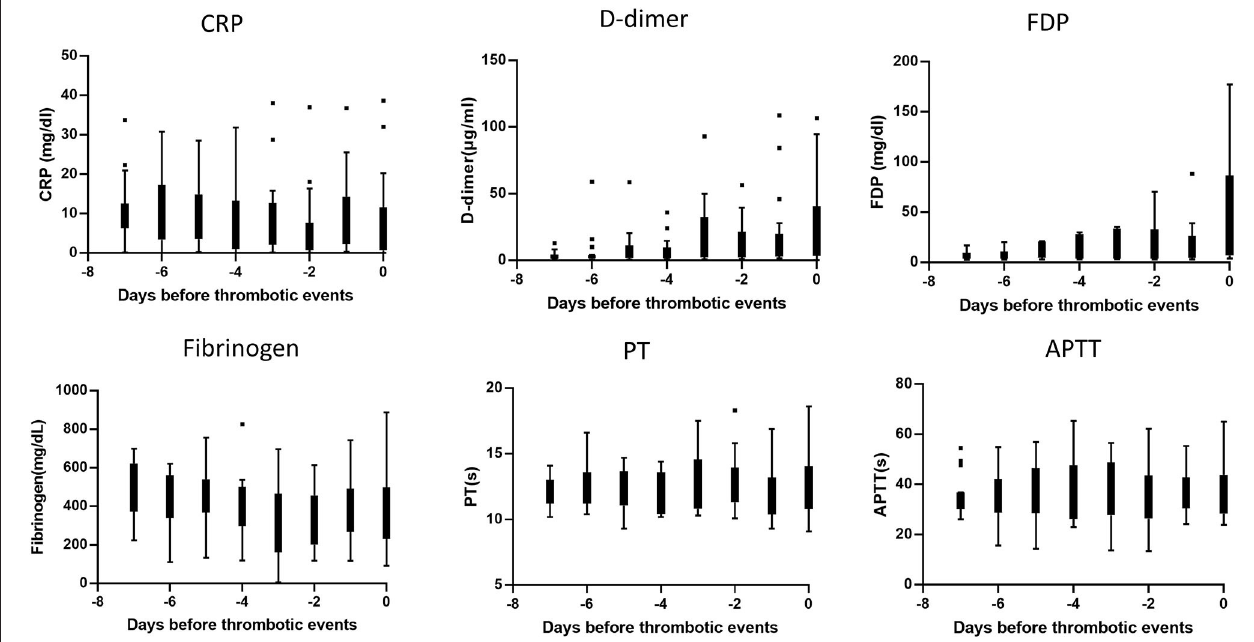
FIGURE 2 | Sequential changes of the biomarkers before the development of thrombosis. Each graph indicated the sequential change of individual biomarkers until the day of thrombotic events. The box-whisker plot indicated median and upper/lower quartile of the data of 32 patients complicated with thrombosis.